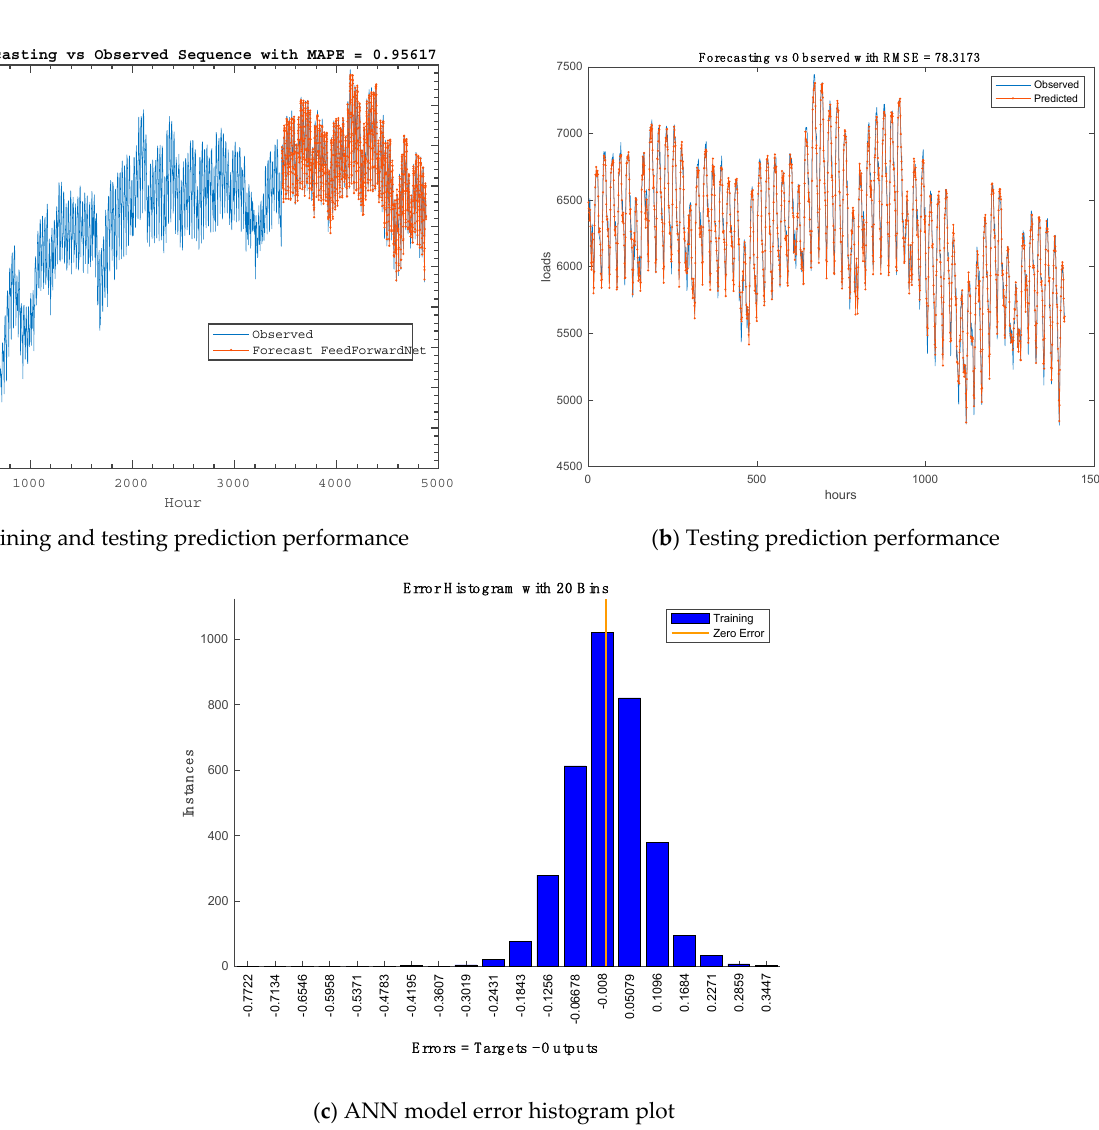
Figure 13. ANN model prediction performance for the Jeddah load: ( a ) training and testing, ( b ) testing, and ( c ) error histogram